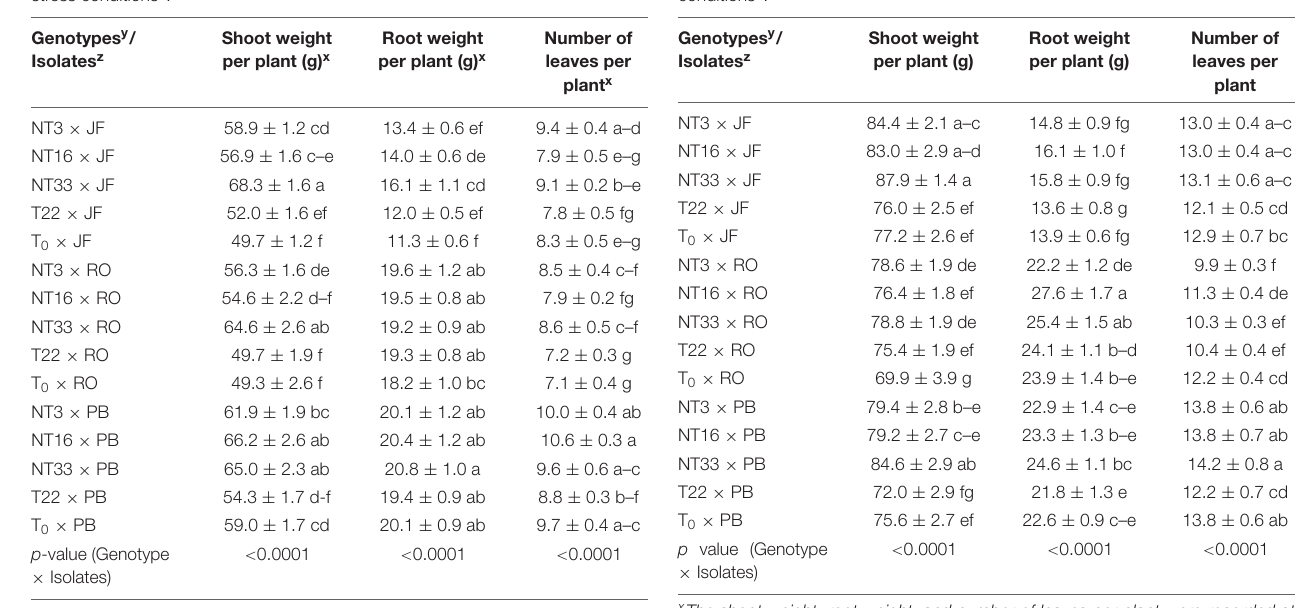
TABLE 2 | Effect of four Trichoderma isolates on fresh shoot weight, fresh root weight, and number of leaves on three tomato genotypes under irrigated conditions x